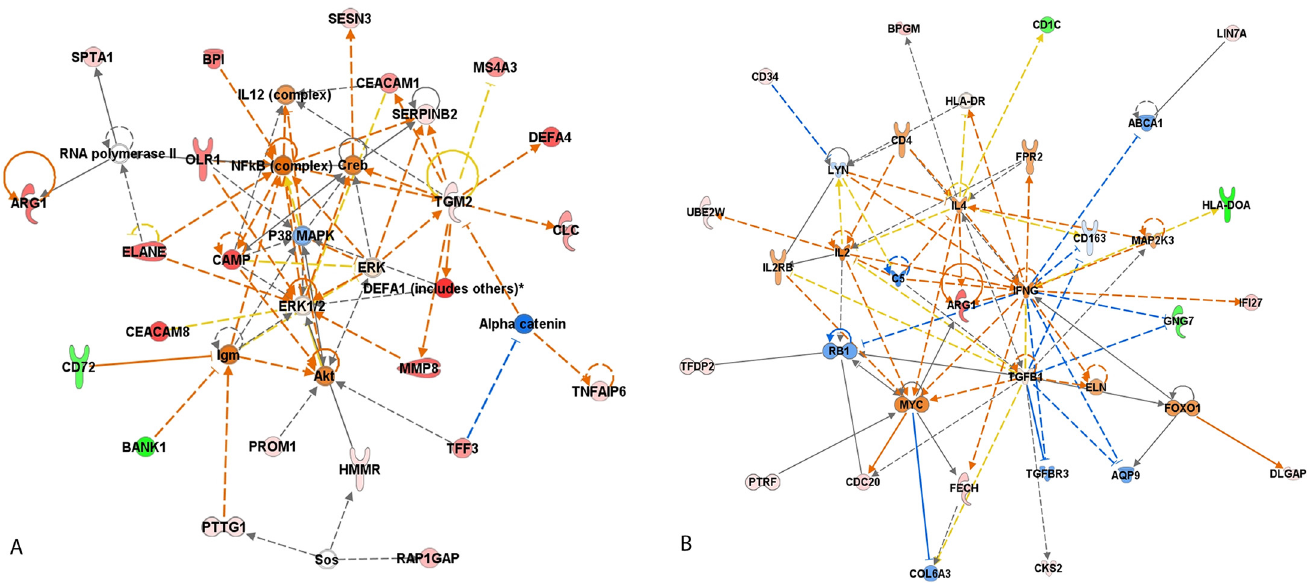
Fig 3. Top interaction networks for the 67 DEG in PBC of patients with abnormal decline of LVEF after DOX-chemotherapy identified by Ingenuity pathway analysis. (A) Network 1 “ Connective tissue disorder, Immunological disease, Inflammatory disease ” ; (B) Network 2 “ Cellular movement, Hematological system development and function, Immune cell trafficking ” . Red filled (up-regulation) and Green filled (down-regulation); Blue line (leads to inhibition); Orange line (leads to activation); Black line (effect not predicted).